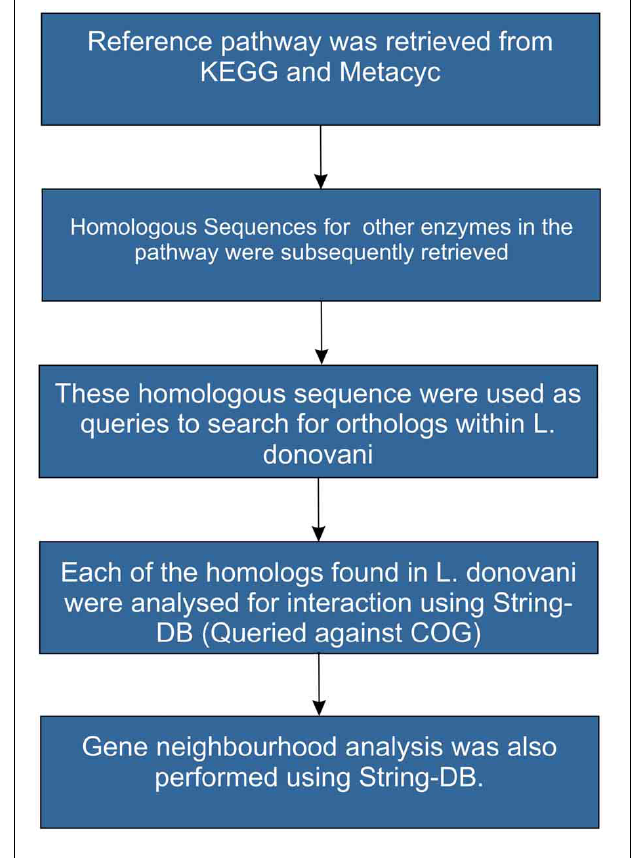
FIGURE 3 | Protocol depicting steps in homology based pathway